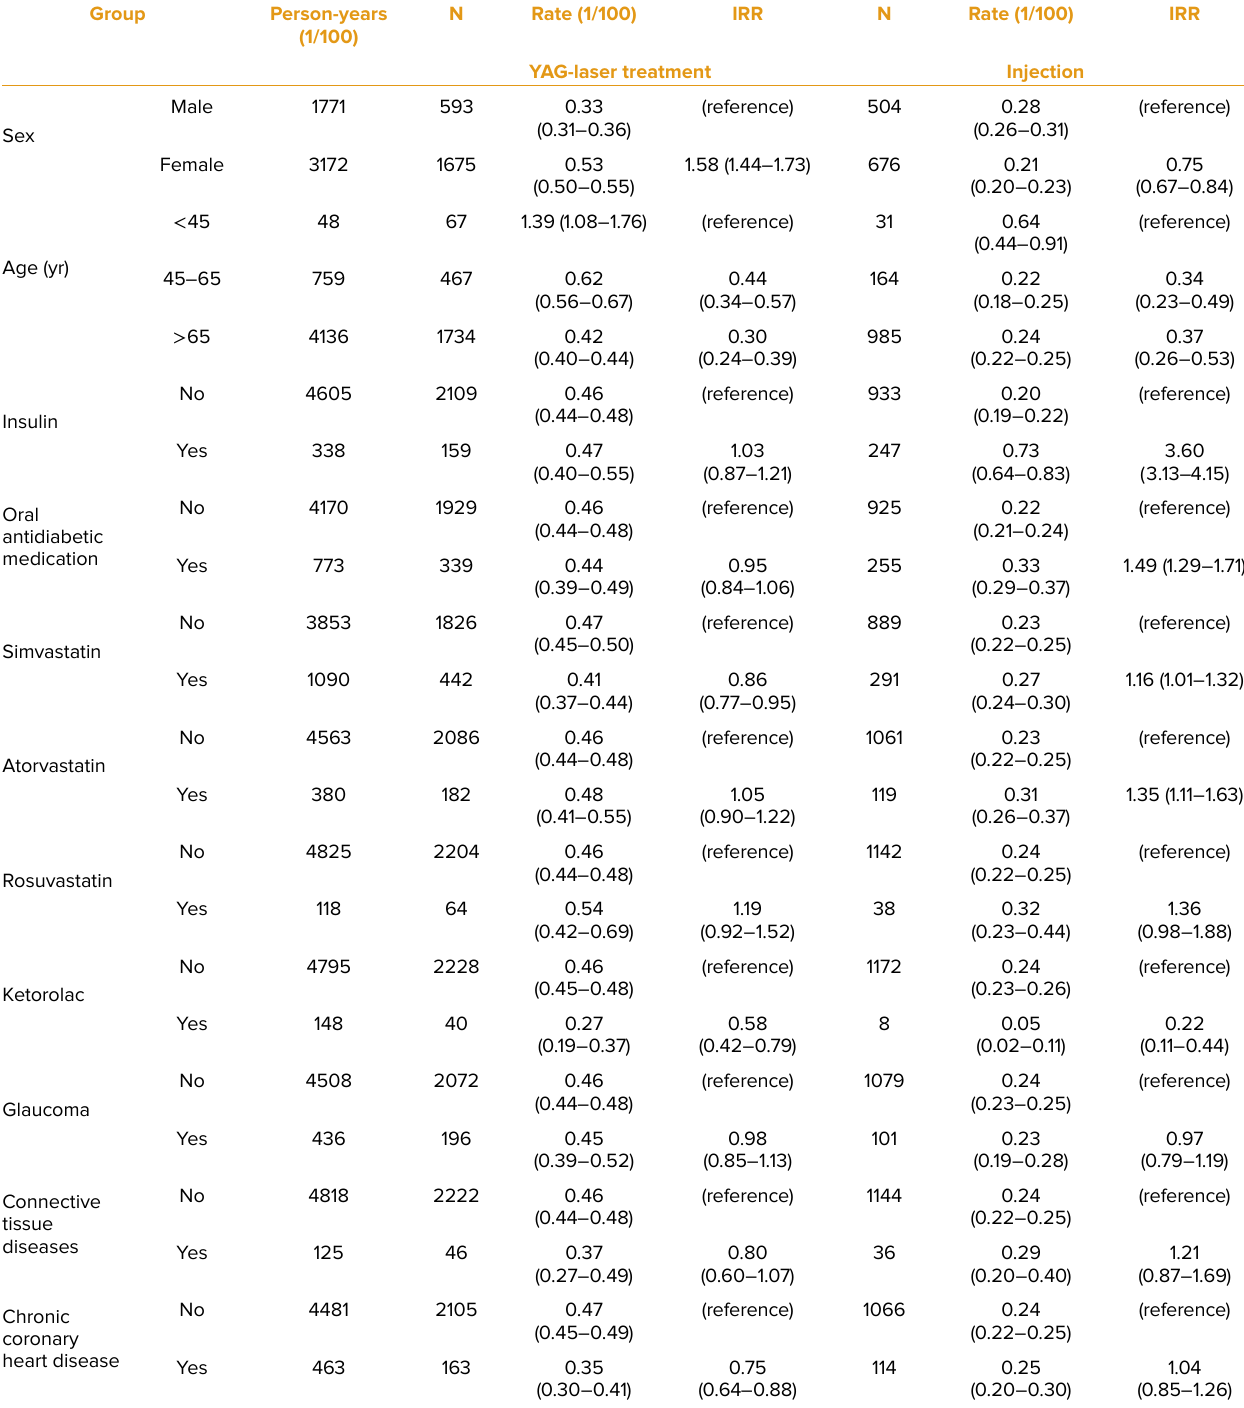
Table 2. Incidence rates (per 100 person-years) for Nd:YAG laser capsulotomy and intravitreal anti-VEGF injection with 95% confidence interval. Incidence rate ratio (IRR) from univariate Poisson model with 95% confidence